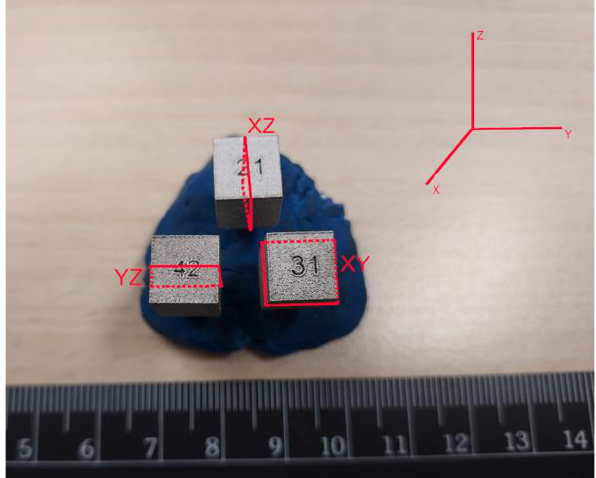
Figure 4. Cutting planes to carry out the microstructure inspection.